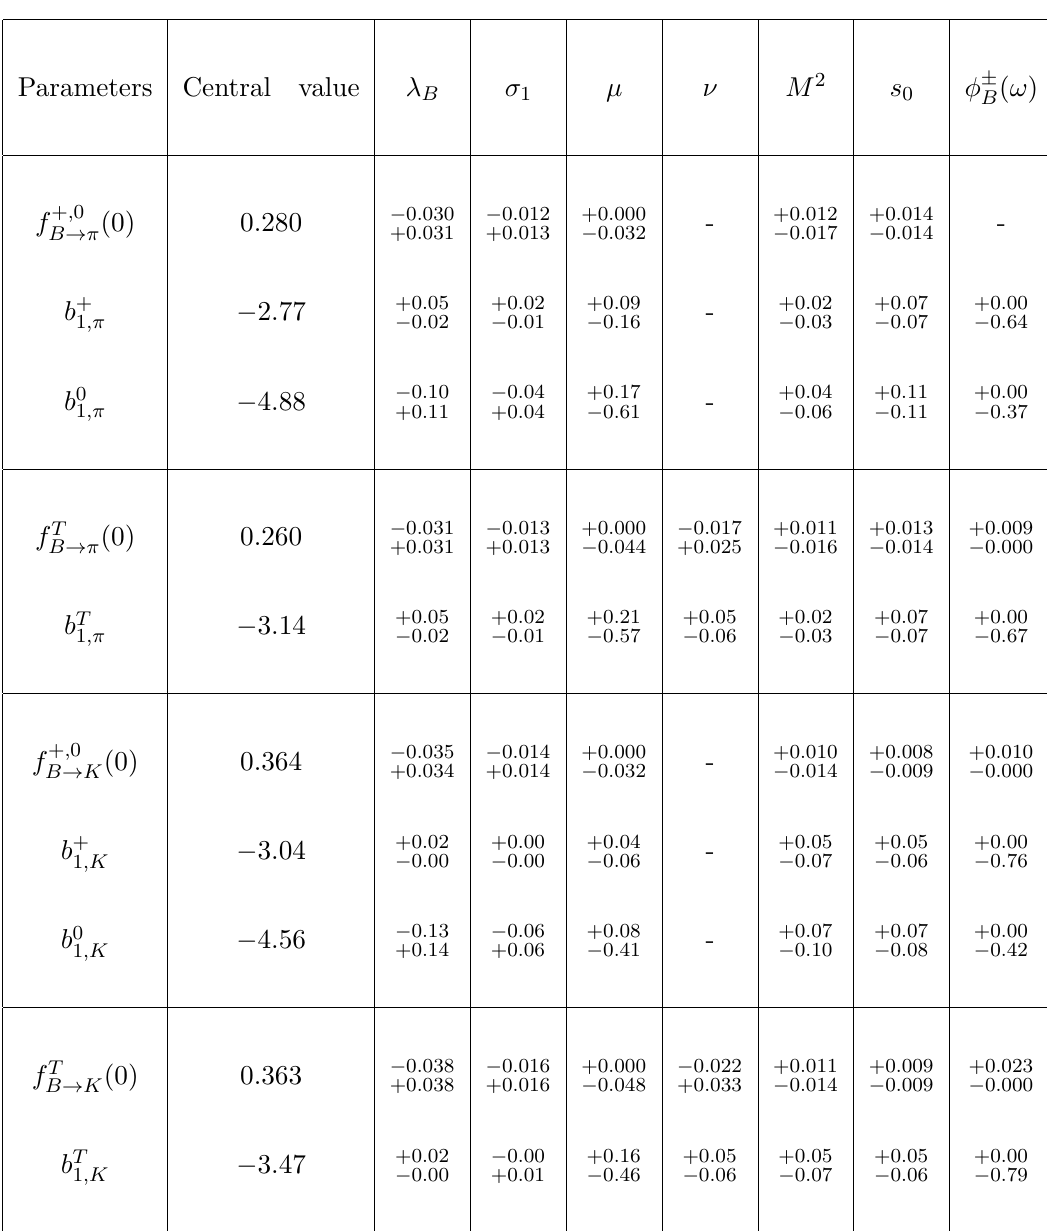
Table 2 . Theory predictions for the shape parameters and the normalizations of B ! (cid:25); K form factors at q 2 = 0 entering the z expansion (5.15) with the dominant uncertainties from variations of di(cid:11)erent input